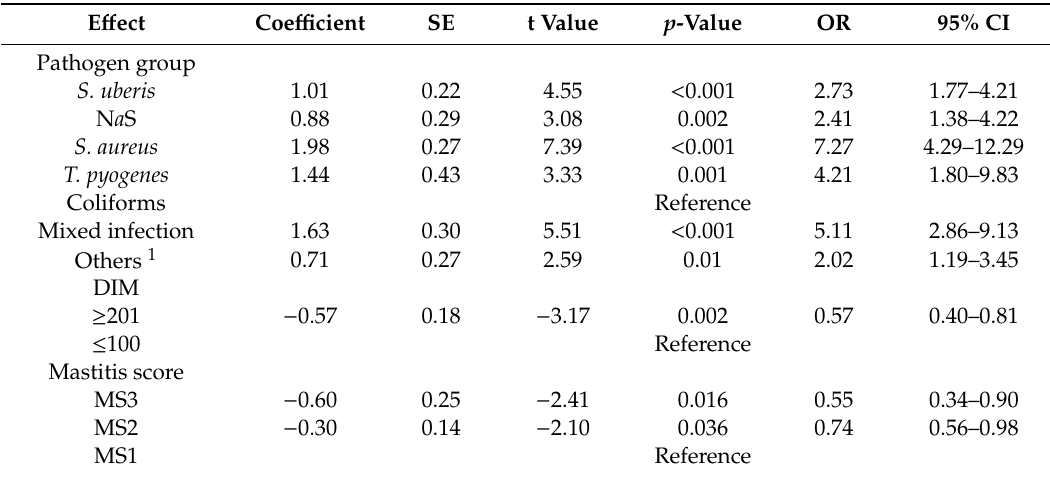
Table5. Finalmixedlogisticregressionmodelforbacteriologicalcureofclinicalmastitisfrom12di ff erent herds in Northern Germany. E ff ect Coe ffi cient